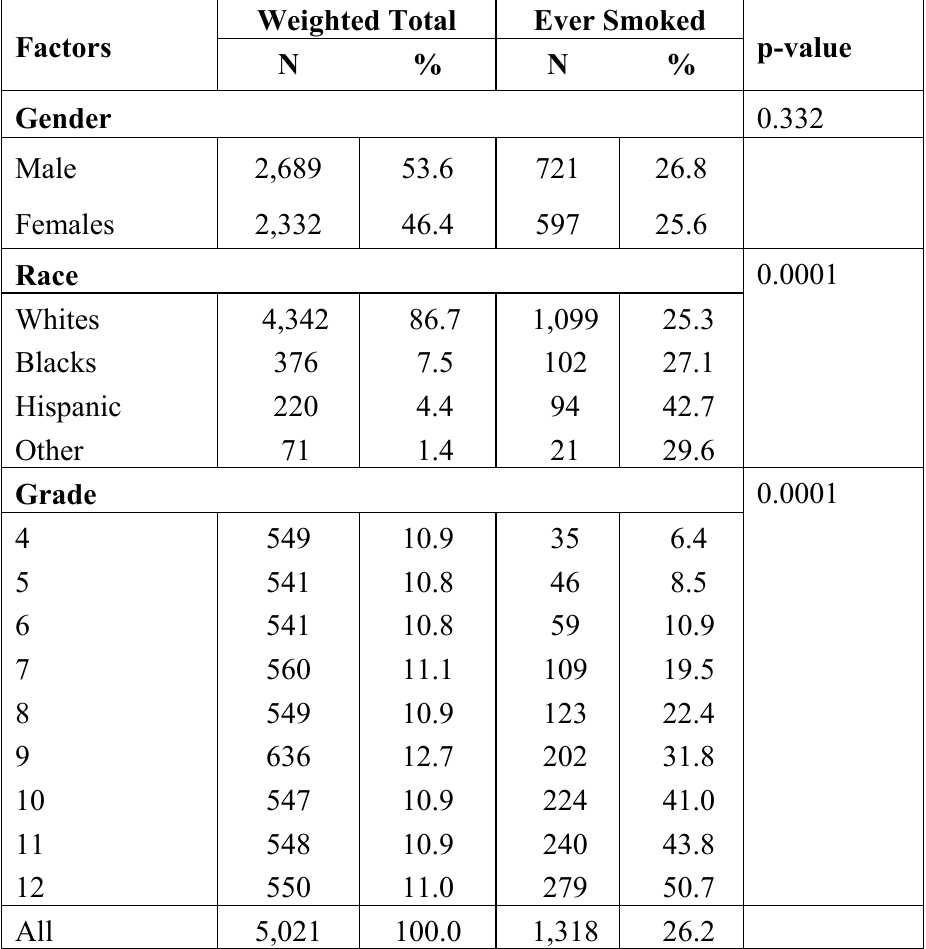
Table 1. The distribution of smoking initiation by gender, race and grade